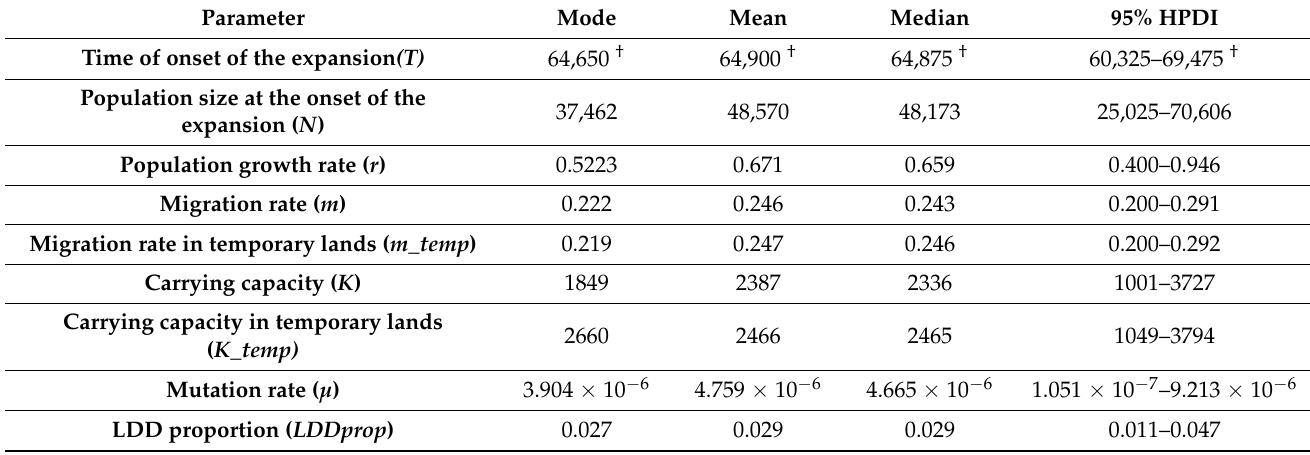
Table 2. Population genetic parameters estimated under the best-fitting evolutionary scenario ( LGP&LDD ). Note that the migration rate and carrying capacity were separately estimated for demes belonging to permanent ( m and K ) and temporary ( m_temp and K_temp ) lands. For each parameter the table presents the mode, mean, median and 95% HPDI of the posterior distribution. A graphical representation of these posterior distributions is provided in Figure